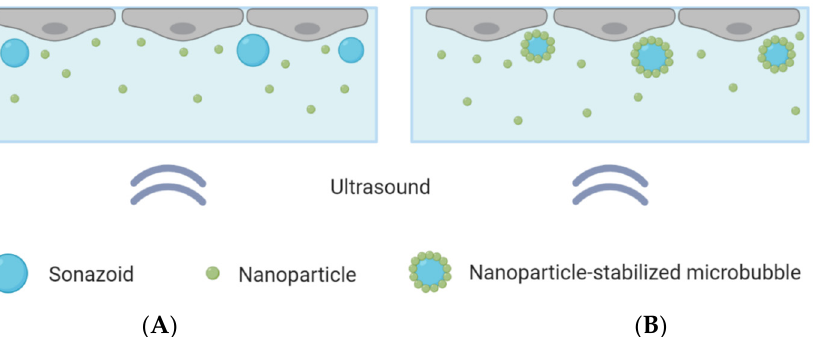
Figure 1. Schematic overview of the CLINIcell with a cell layer on top, microbubbles and na- noparticles in solution and ultrasound applied from below. ( A ): Cells exposed to nanoparticles co-incubated with Sonazoid. ( B ): Cells exposed to nanoparticle-loaded microbubbles and an excess of